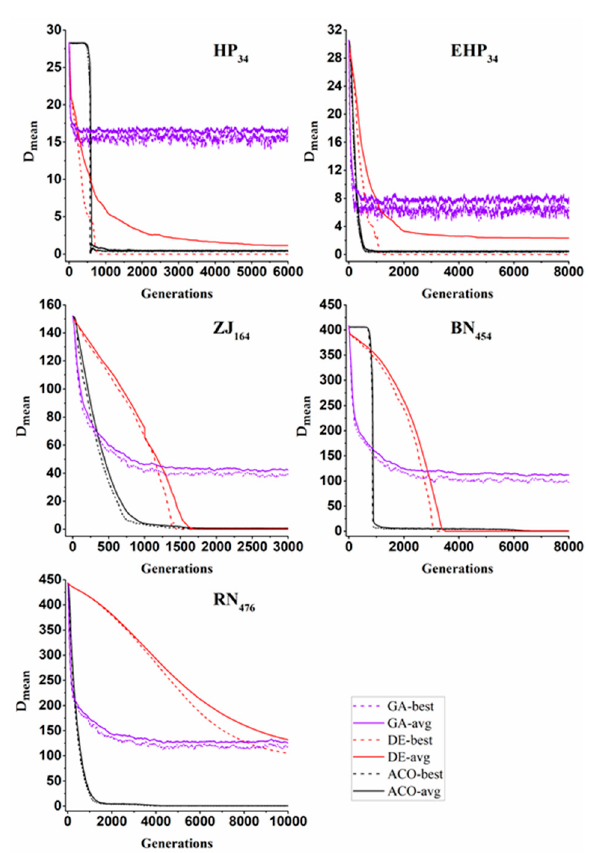
Figure 5. Solution quality metric D mean ( G ) of the three di ff erent types of EAs applied to the five case studies.